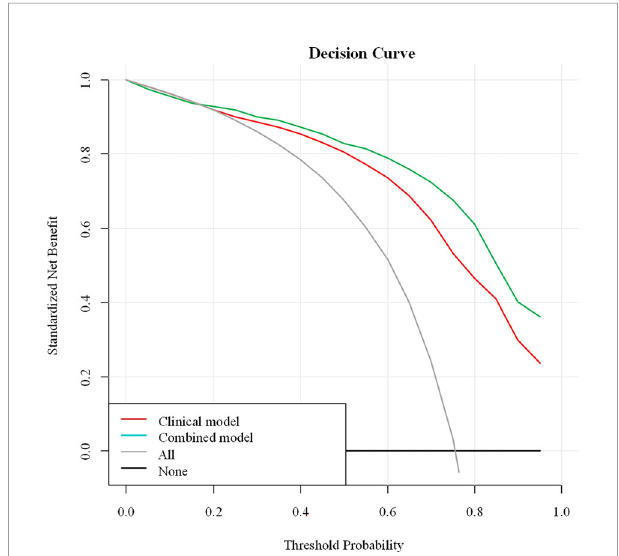
FIGURE 5 | Decision curve analysis of the combined model. The Y-axis demonstrates the net bene fi t to patients. As indicated in the curve, the net bene fi t of using the combined model to differentiate benign and malignant NME lesions is greater than when the clinical model is used at a threshold probability of >